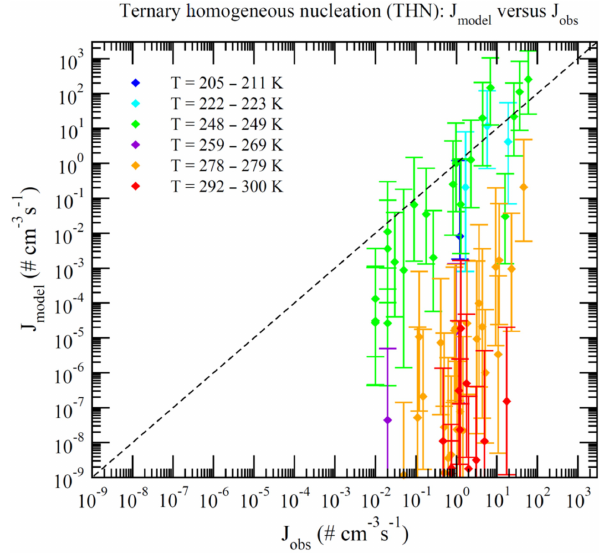
Figure 3. Same as Fig. 1 but for THN conditions (no ionization, [ NH ] > 0 . 3